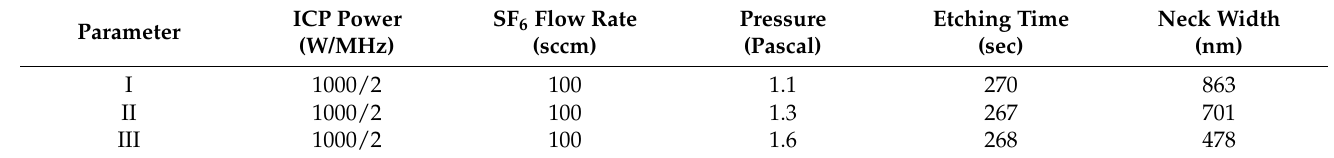
Table 1. ICP etching